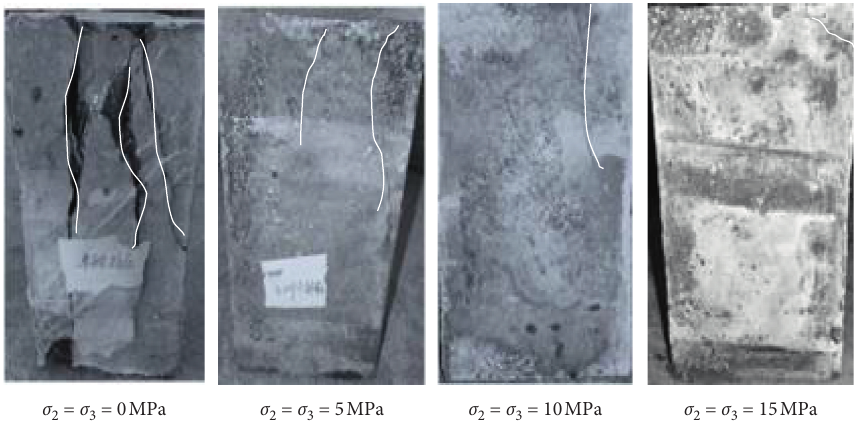
Figure 10: Cracking of rock-like specimen with different confining